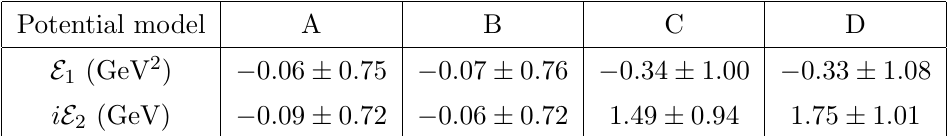
Table 4 . Results of the (cid:12)t of the gluonic correlators E 1 and i E 2 , when the wavefunctions and binding energies are computed within the potential models described in section